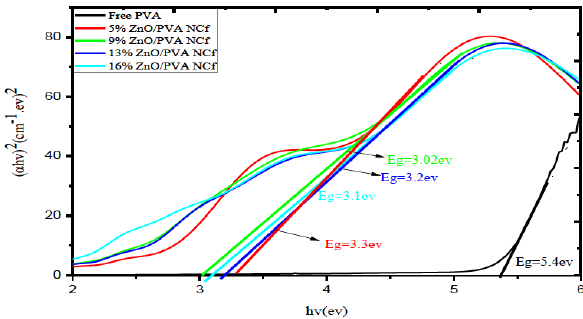
Figure 9: Band gap energy of casted PVA film and ZnO/PVA compos- ite